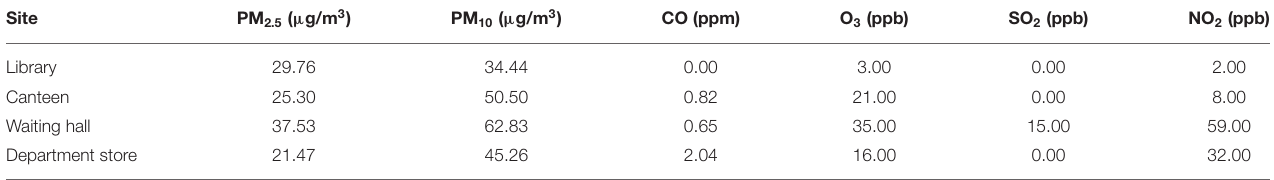
TABLE 4 | Air quality field test data.